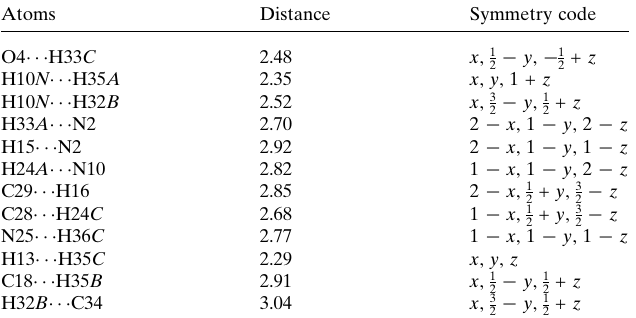
Table 3 Experimental details. Crystal data Chemical